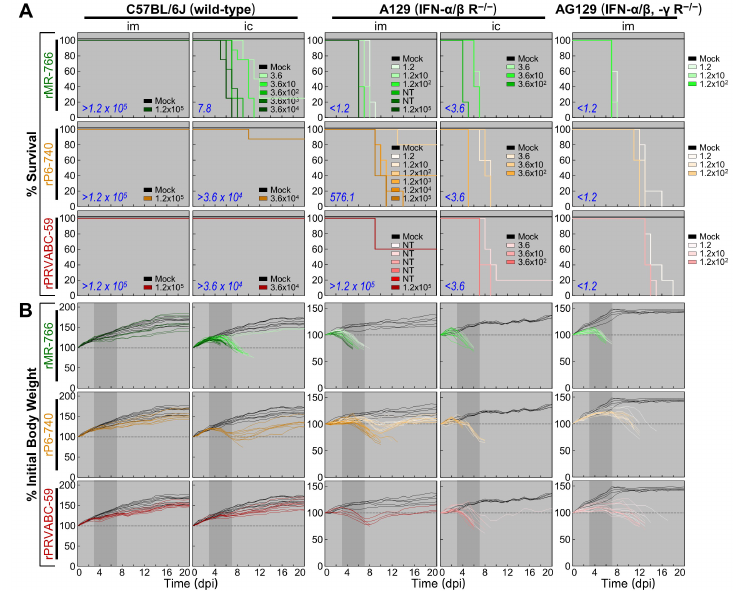
Figure 9. Three molecularly cloned ZIKVs show a full spectrum of variation in IFN sensitivity in mice lacking type I or both type I and II IFN receptors. Groups of 4-week-old C57BL/6J ( n = 8), A129 ( n =